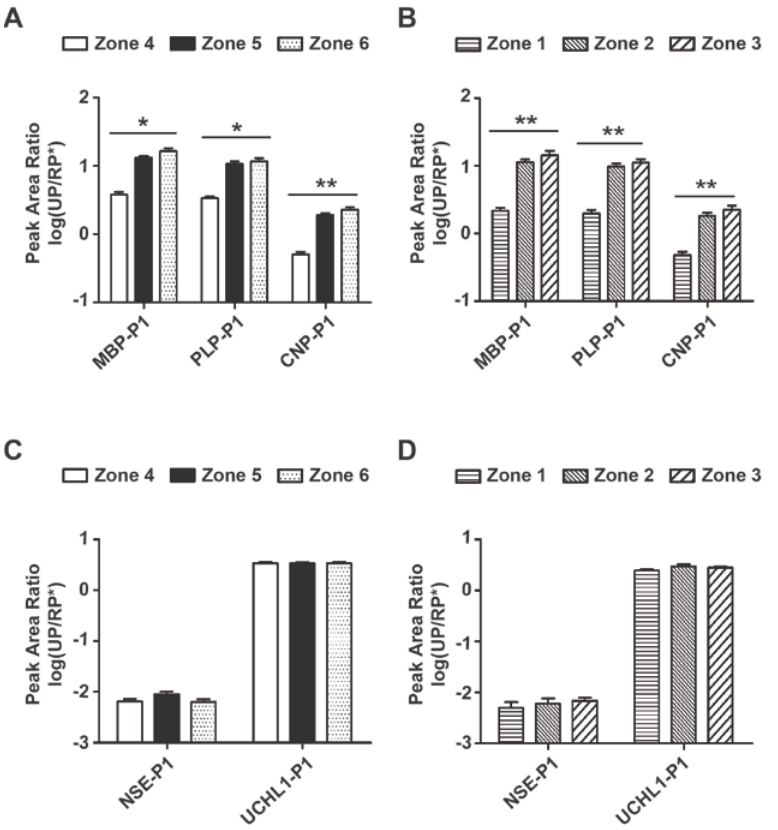
Figure 5. Distribution of myelin proteins and other biomarker candidates in intact and infarcted brain tissue. ( A ) Three myelin proteins from zones 4–6 of intact brain tissues were verified and semi-quantified by LCM–LRP. Each protein was verified by 2–4 unique peptides and quantified by the peak area. Peak area ratios of unique peptides to RP* were calculated (UP/RP*) ( n = 12); ( B ) Three unique myelin proteins in zones 1–3 of infarcted brain tissue were collected by LCM, and then the peak area ratios of 3 unique peptides to RP* were calculated (UP/RP*) ( n = 12); ( C ) Two protein biomarker candidates from zones 4–6 were verified by 2–3 unique peptides for each and quantified by the peak area. Peak area ratios of unique peptides to RP* were calculated (UP/RP*) ( n = 12); ( D ) The peak area ratios of NSE-P1 and UCHL1-P1 (UP/RP*) in zones 1–3 were calculated ( n = 12). Unique peptide 1 for myelin basic protein (MBP-P1), DTGILDSIGR; unique peptide 1 for myelin proteolipid protein (PLP-P1), TSASIGSLCADAR; unique peptide 1 for 2′,3′-cyclic-nucleotide 3′-phosphodiesterase (CNP-P1), AIFTGYYGK; unique peptide 1 for neuron-specific enolase (NSE-P1), LGAEVYHTLK; unique peptide 1 for ubiquitin carboxyl-terminal hydrolase isozyme L1 (UCHL1-P1), FSAVALCK. * p < 0.05; ** p < 0.01. Neuron-specific enolase (NSE) is a glycolytic enzyme in neurons, also known as gamma-enolase or enolase 2 (ENO2). Ubiquitin carboxyl-terminal hydrolase isozyme L1 (UCHL1) is abundantly present in all neurons [24]. Both NSE and UCHL1 are soluble proteins in the cytoplasm that are not thought to be site-specific, and our results confirm that they are evenly distributed in zones 4–6 and 1–3 (Figure